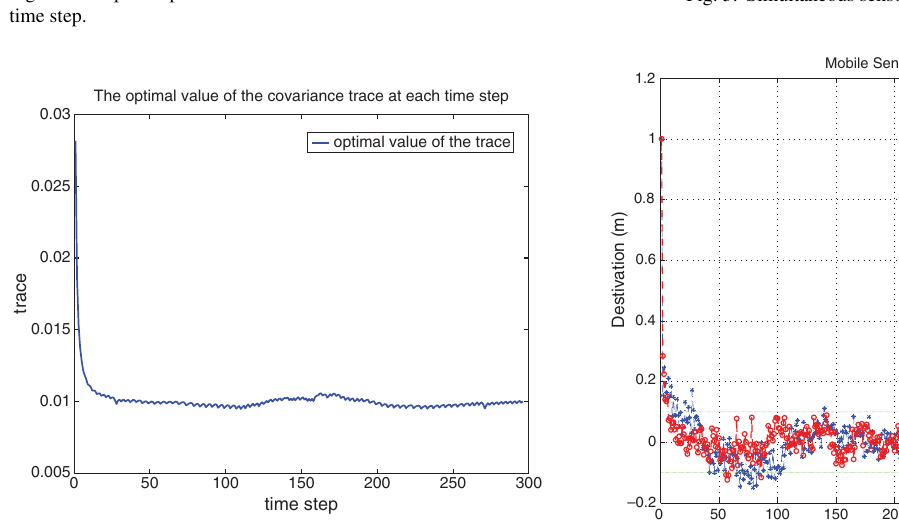
Fig. 5. Simultaneous sensor nodes localization.